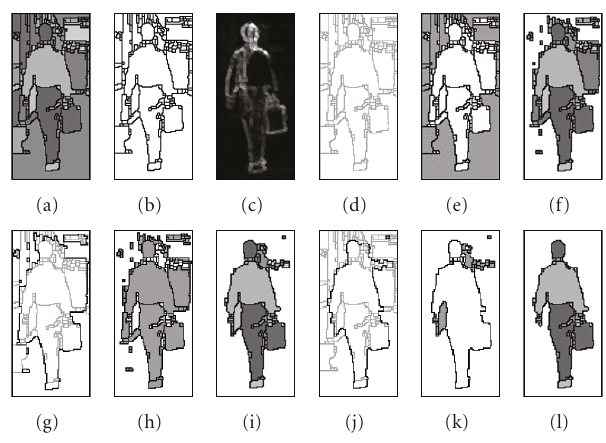
Figure 7: Segmentation of moving object from moving